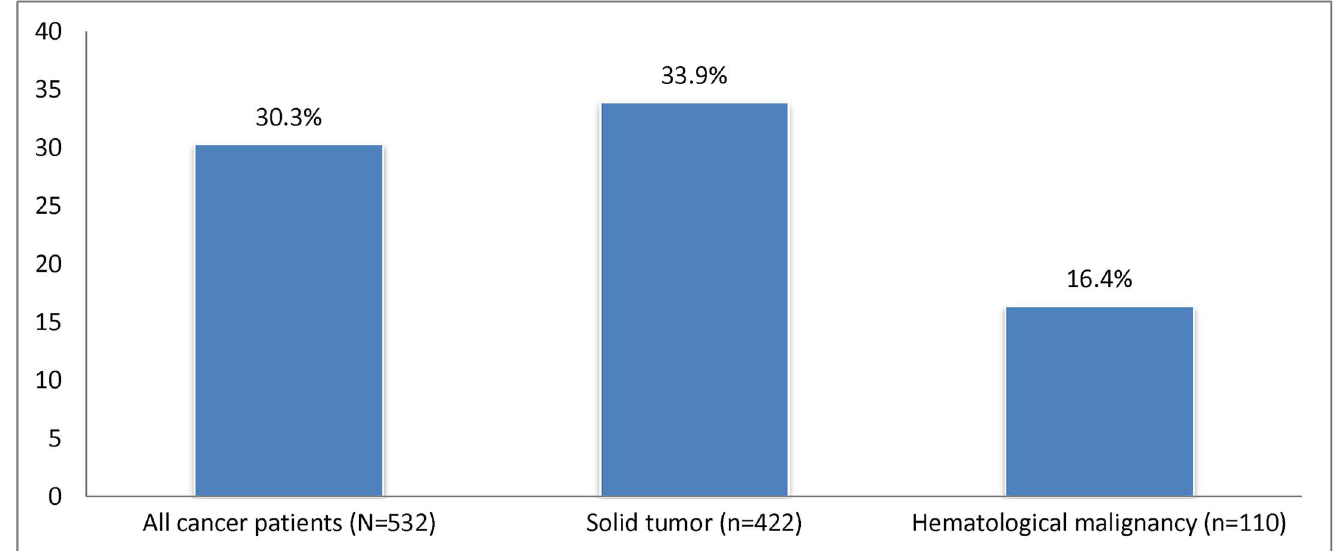
Fig 3. Frequency of patients’ contact with the hospital palliative care team.